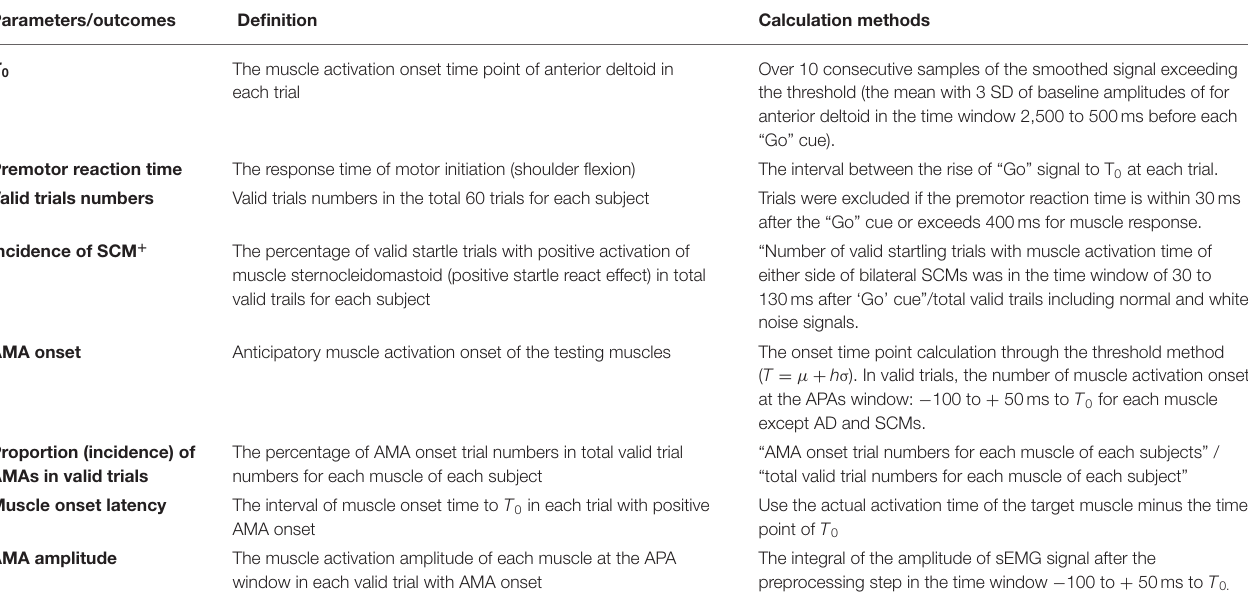
TABLE 2 | The definition and calculation process of the parameters and outcome